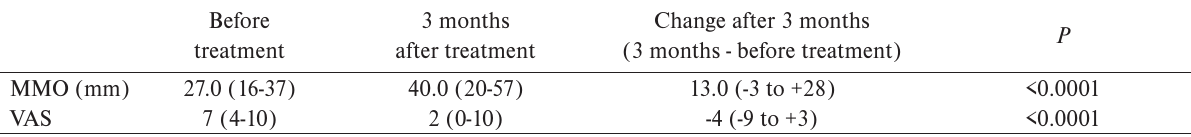
Table 1. Evaluation of the significance of the change in the parameters after treatment. Before